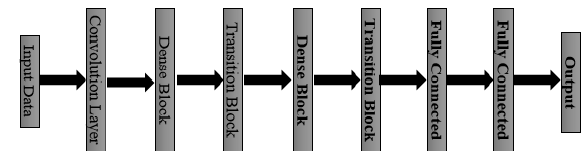
Figure 2 . The architecture of DenseNet for oil spill detection.